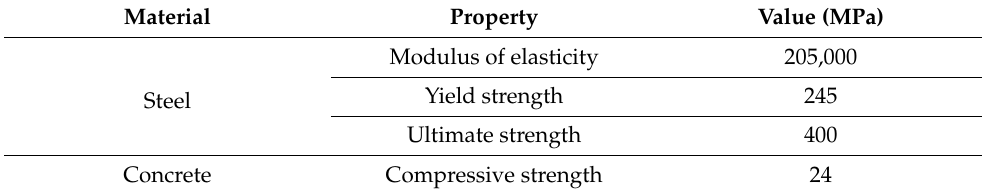
Table 1. Material properties for section design.